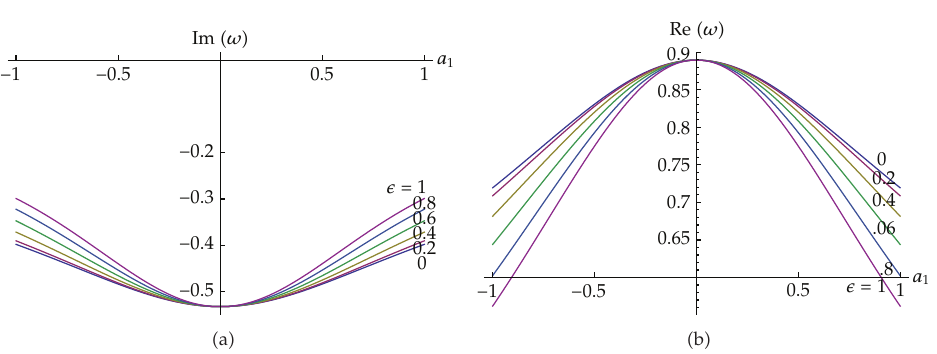
Figure 1: An example of the D (cid:8) 6 fundamental (cid:2) j,m 1 ,m 2 ,n 1 ,n 2 (cid:3) (cid:8) (cid:2) 0 , 0 , 0 , 0 , 0 (cid:3) QNM. (cid:2) a (cid:3) is a plot of the imaginary part and (cid:2) b (cid:3) is a plot of the real